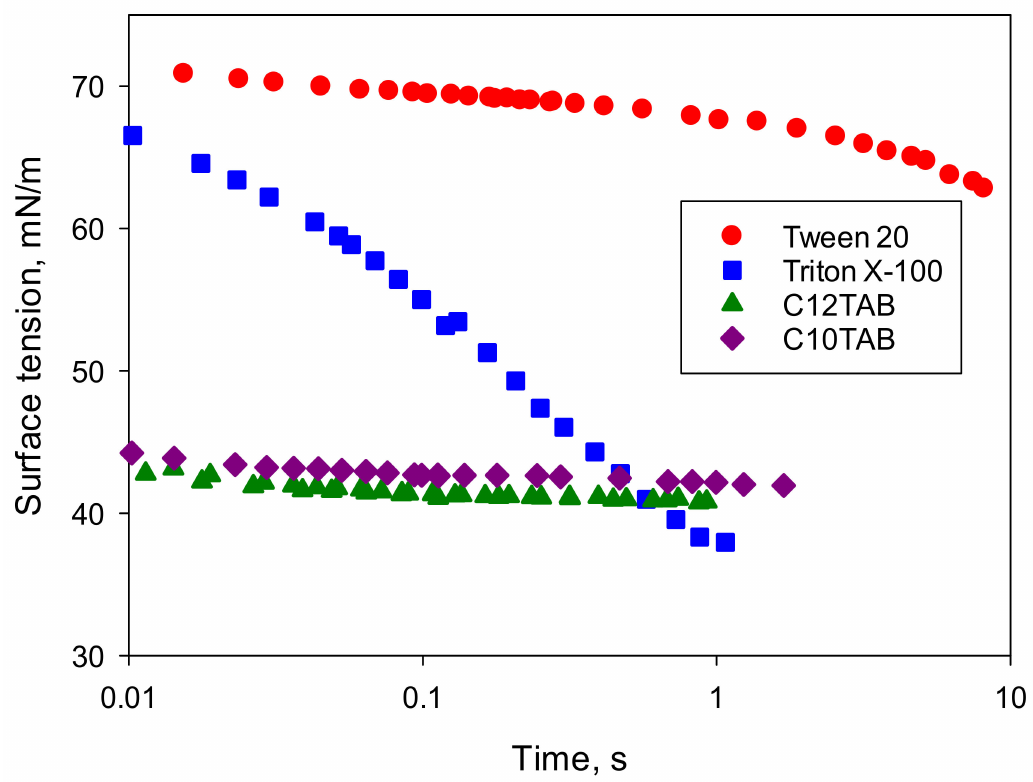
Figure 6. Dynamic surface tension of surfactant solutions in the glycerol/water mixture at concentrations equal to CMC values. A concentration of 0.06 mM is used for Tween 20. For C 10 TAB and C 12 TAB, the equilibrium surface tension was reached at t < 0.01 s, for Triton X100 it was reached at t ~ 1 s; for Tween 20, surface tension was far from equilibrium at t = 10